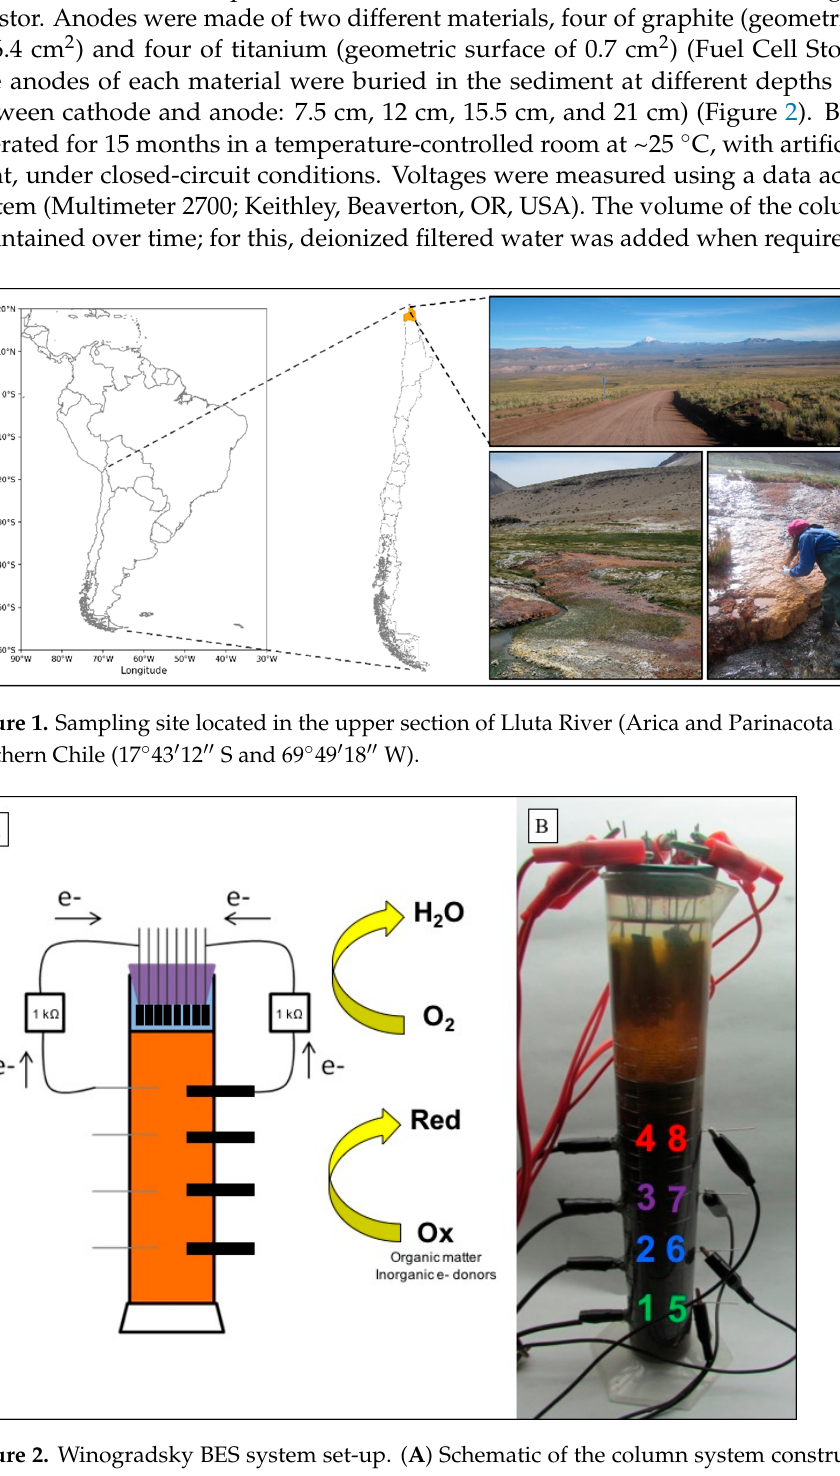
Figure 2. Winogradsky BES system set-up. ( A ) Schematic of the column system constructed with eight carbon felt cathodes (in water), each connected to eight anodes inserted in the sediment. ( B ) Photography of one of the two columns tested in the laboratory. Eight anodes were inserted in the sediment (1–4 graphite rod anodes, 5–8 titanium wire anodes). Colors were used for different cathode–anode distances. red: 7.5 cm, purple: 12 cm, blue: 15.5 cm, and green: 21